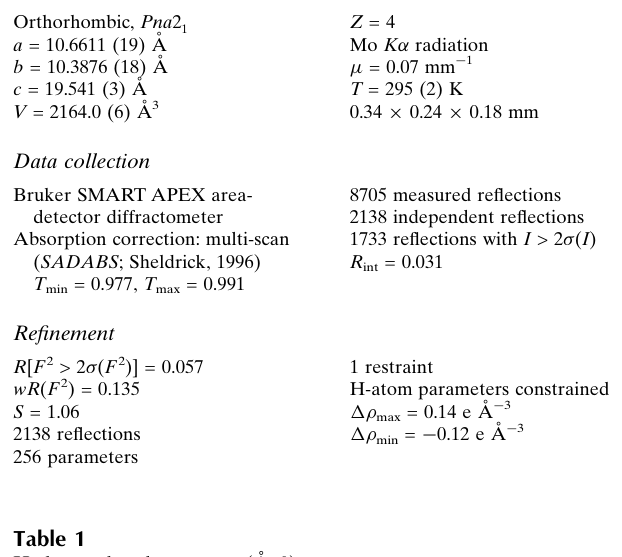
Hydrogen-bond geometry (A˚ , (cid:1)